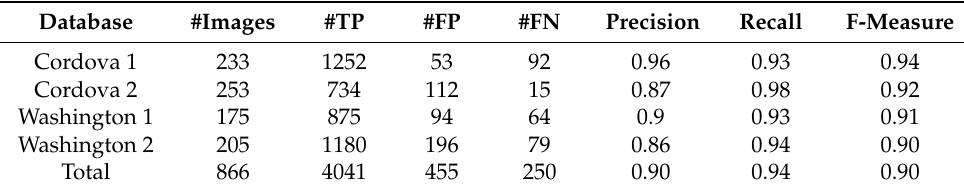
Table 2. Experimental results with Caltech